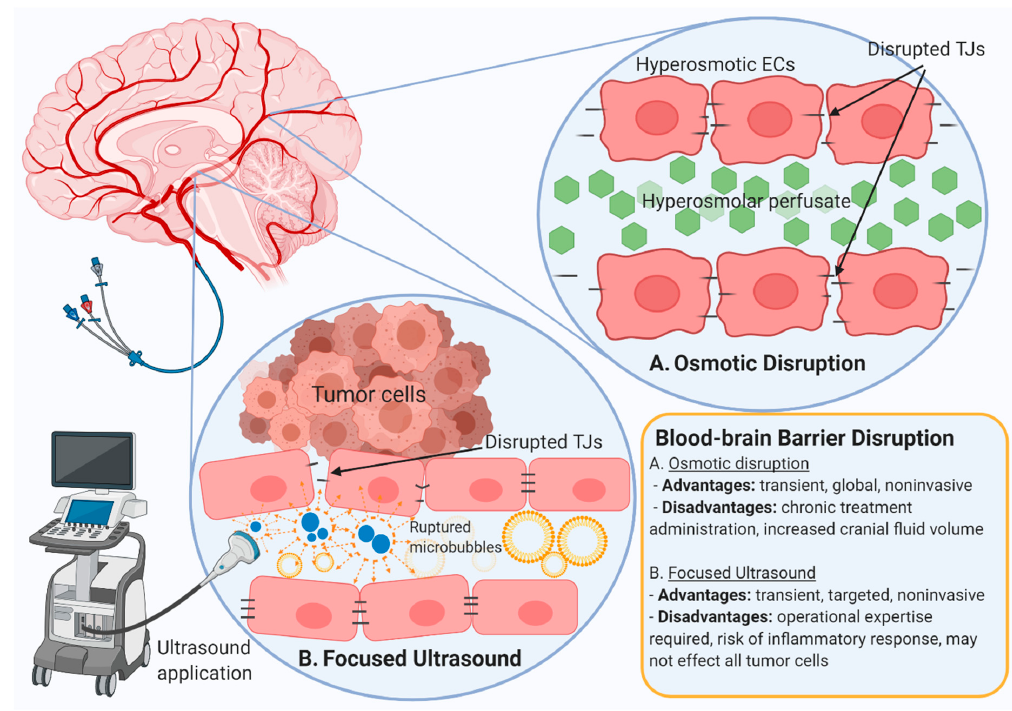
Figure 4. Drug delivery to the brain may be increased by noninvasive BBB disruption